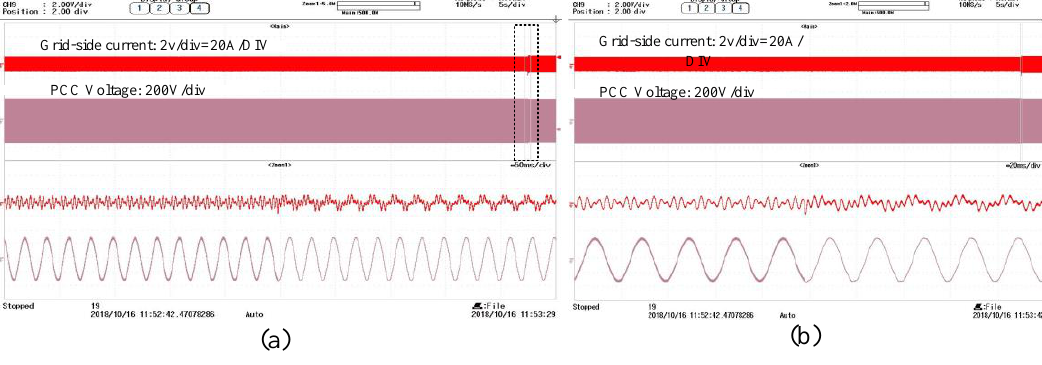
Figure 14. Experimental waveform when the grid impedance changes (C = 600 μF, R = 0.2 Ω, Resonance frequency: 11th). ( a ) The waveform when the harmonic instability occurs; ( b ) zoom of dotted box in ( a ).